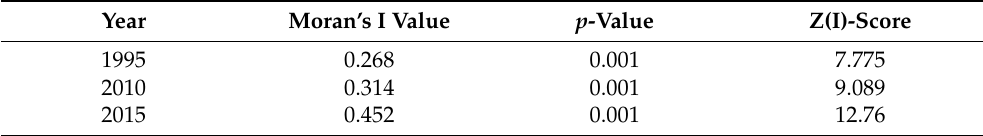
Figure 4. Spatial distribution of luxury hotels in Shanghai City. Table 4. Moran’s I index for luxury hotels in